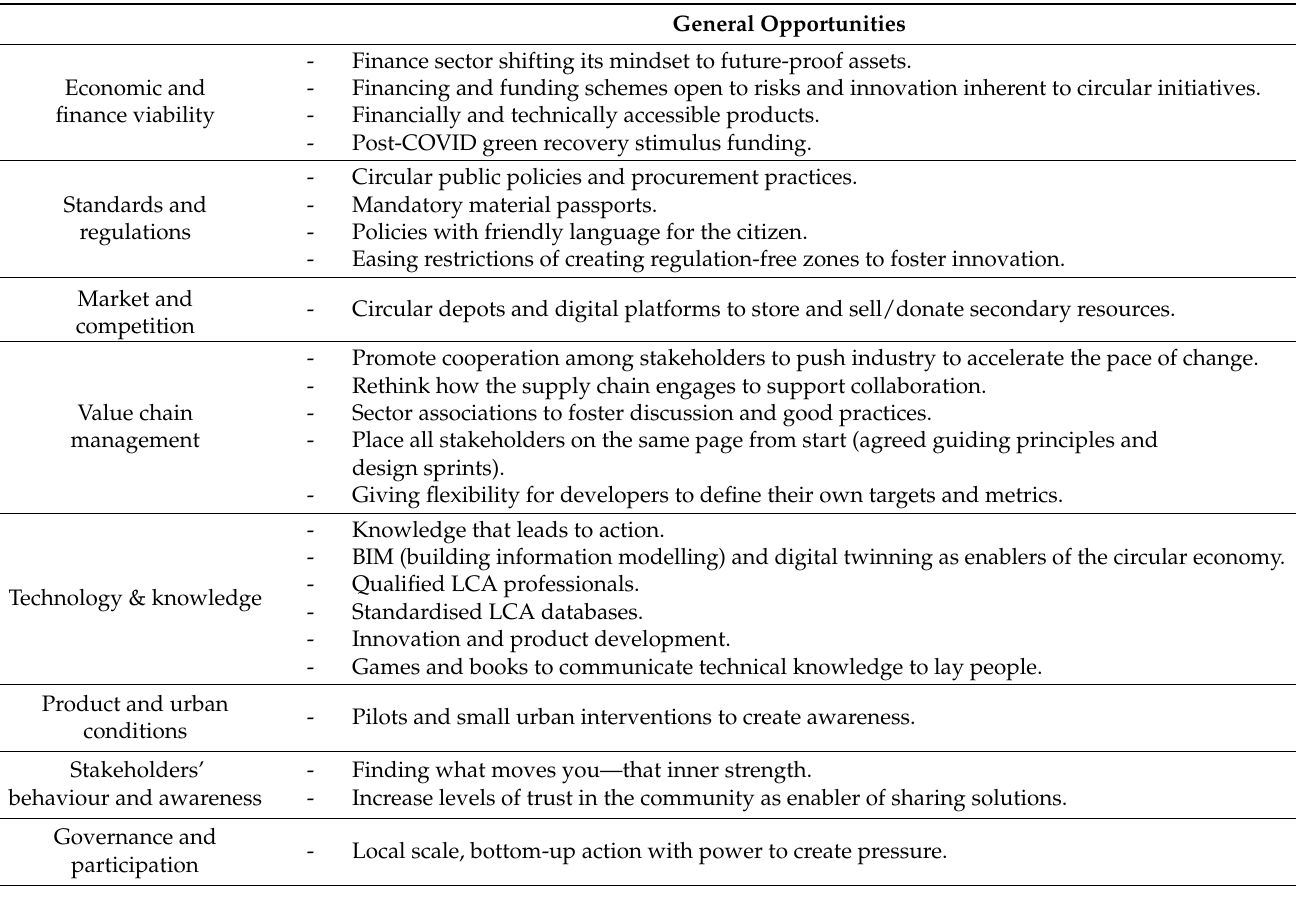
Table 6. Summary of identified opportunities to enable a RC4BE.